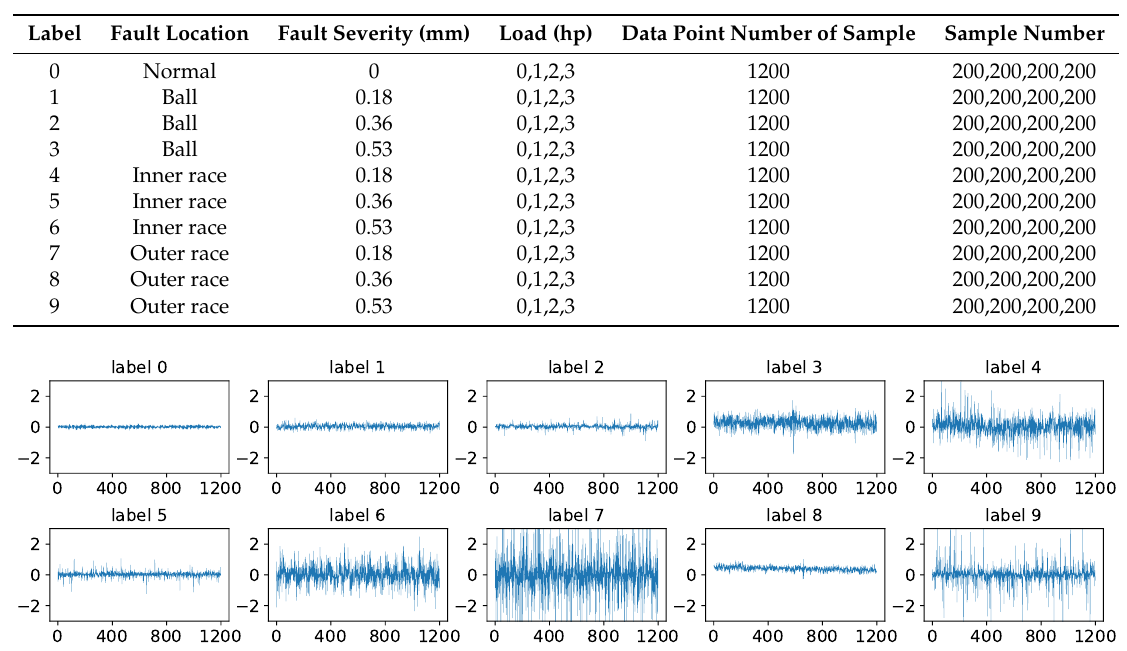
Table 1. Dataset description.